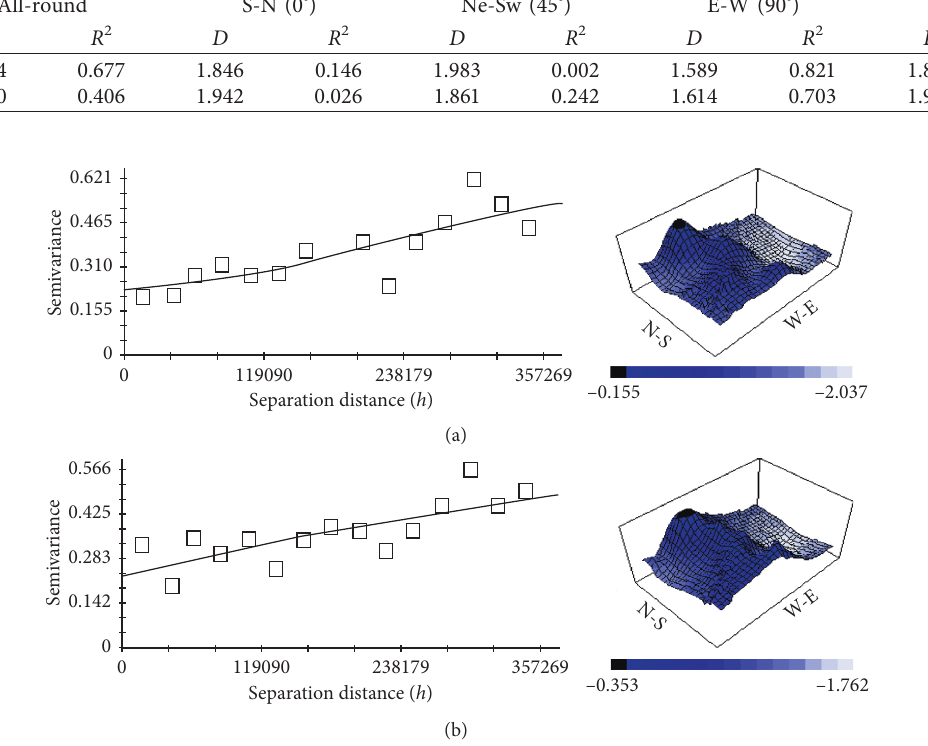
Figure 6: Evolutionary graph of variation function of green utilization efficiency of urban construction land: (a) 2011 and (b) 2015.